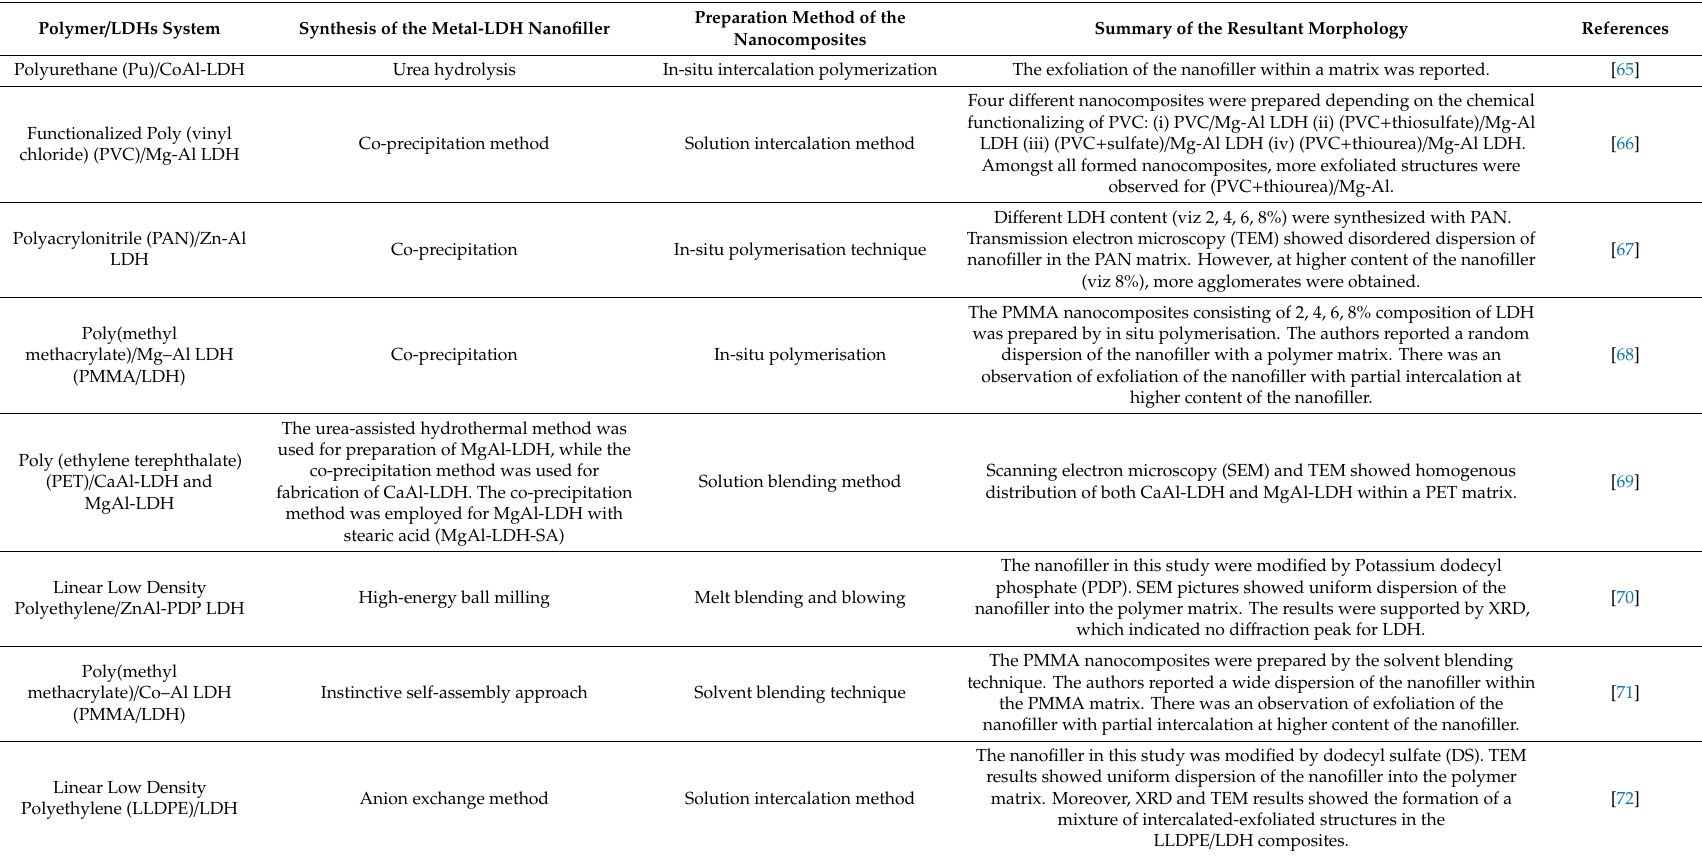
Table 2. Selective studies on preparation and morphology of polymer-LDHs